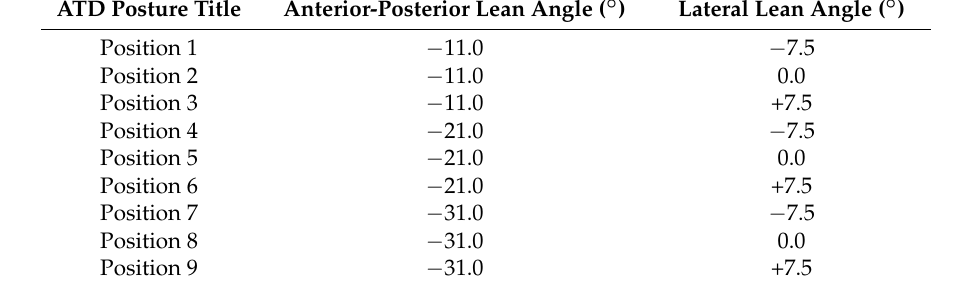
Table 4. Anthropomorphic test device (ATD) positions.